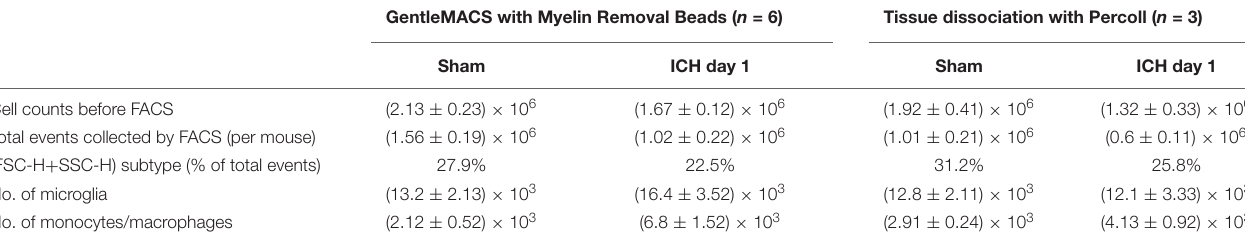
TABLE 1 | Cell numbers by gentleMACS and Percoll methods.